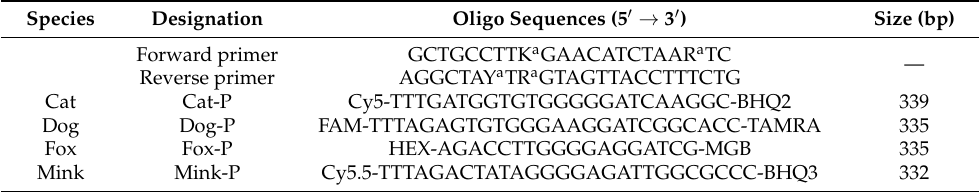
Table 1. Specifications of primers and